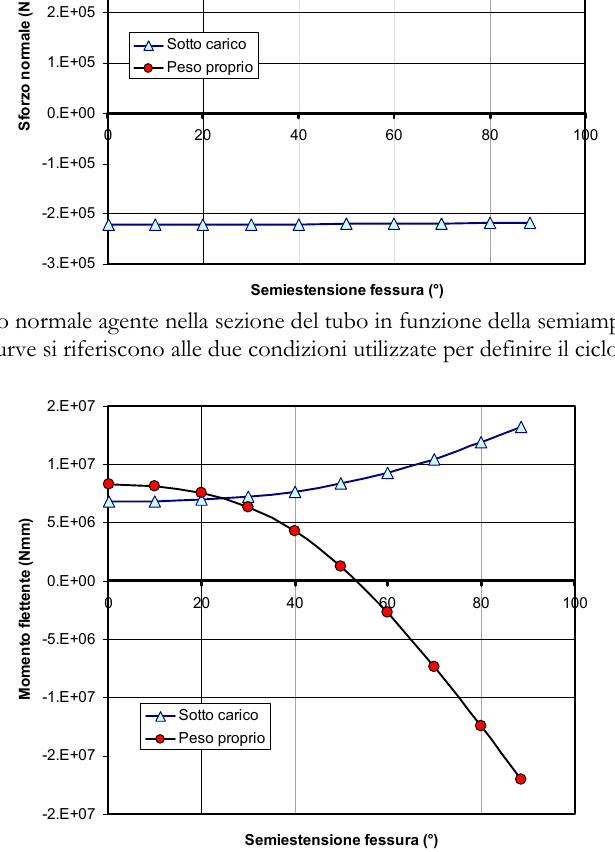
Figura 7: Momento flettente valutato rispetto al baricentro della sezione integra in funzione della semiampiezza del difetto; le curve si riferiscono alle due condizioni di